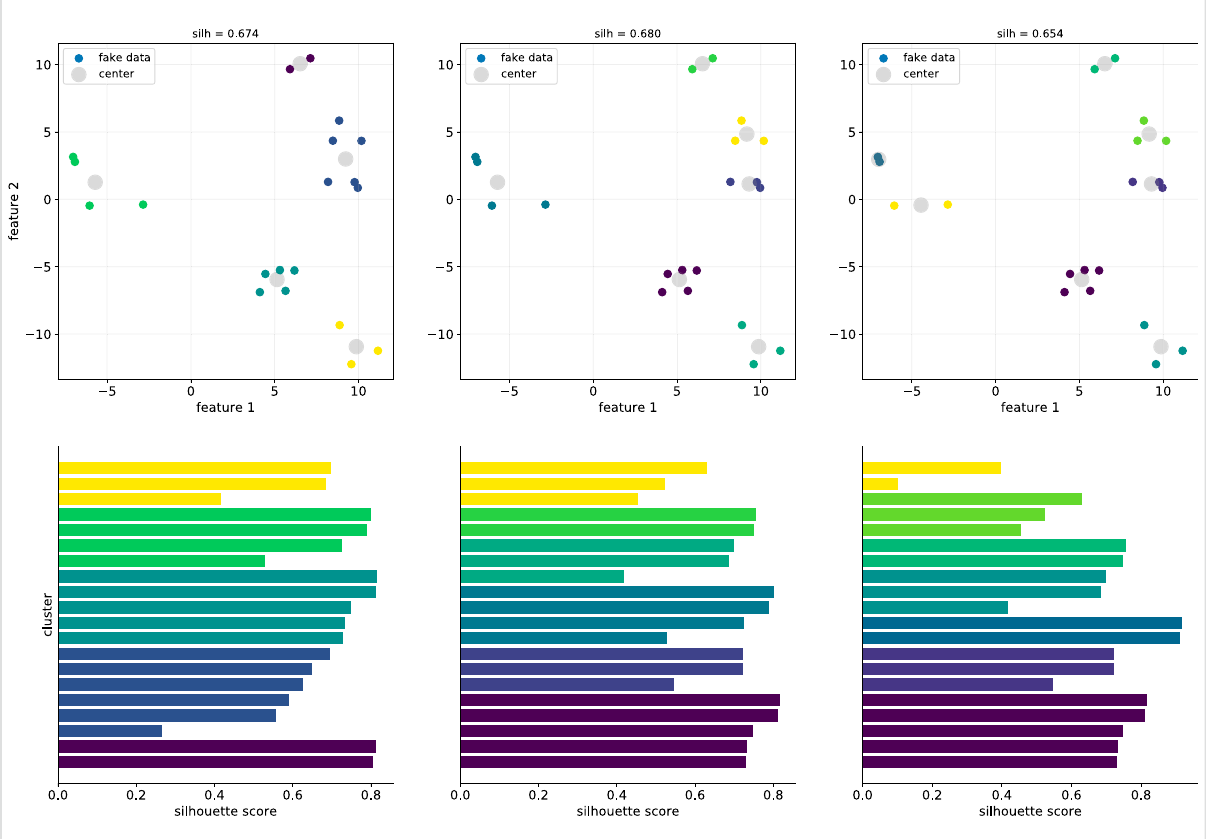
FIGURE 1 Example of forming clusters of three sizes with fake data and generating silhouette scores and diagrams. In the top row, the smaller points are thedatapoints,andthelargergraypointsaretheclustercenters,asdeterminedby k -means.Thesilhouettescoreisgivenatthetopofeachcolumn; thecentercolumnhasthehighestscore.Silhouettediagramsareshowninthediagramsinthebottomrow,colorcodedbytheclustersshowninthe diagramsabovethem.Barlengthsaremostuniforminthemiddlecolumn,indicatingthatnoneofthepointsarepoorlyclustered,andtherefore resulting in the middle column ’ s higher